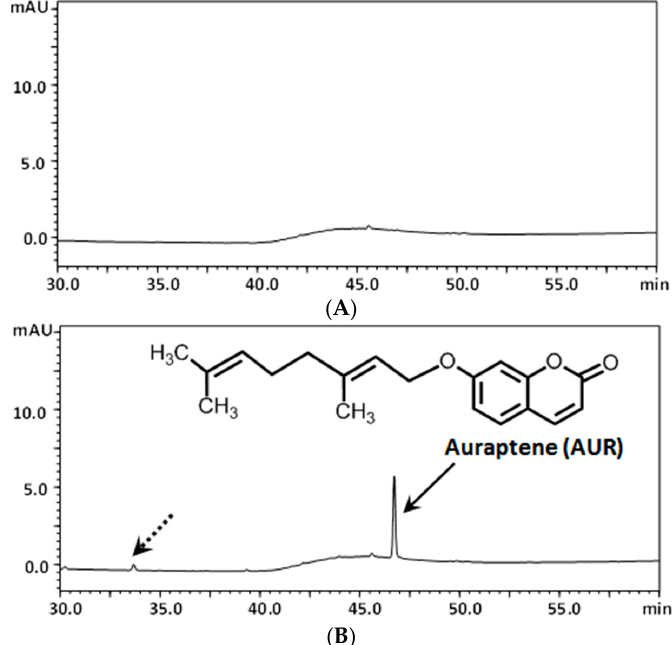
Figure 5. HPLC chromatograms of vehicle-treated brains ( A ); and brains from mice treated i.p. with AUR ( B ).